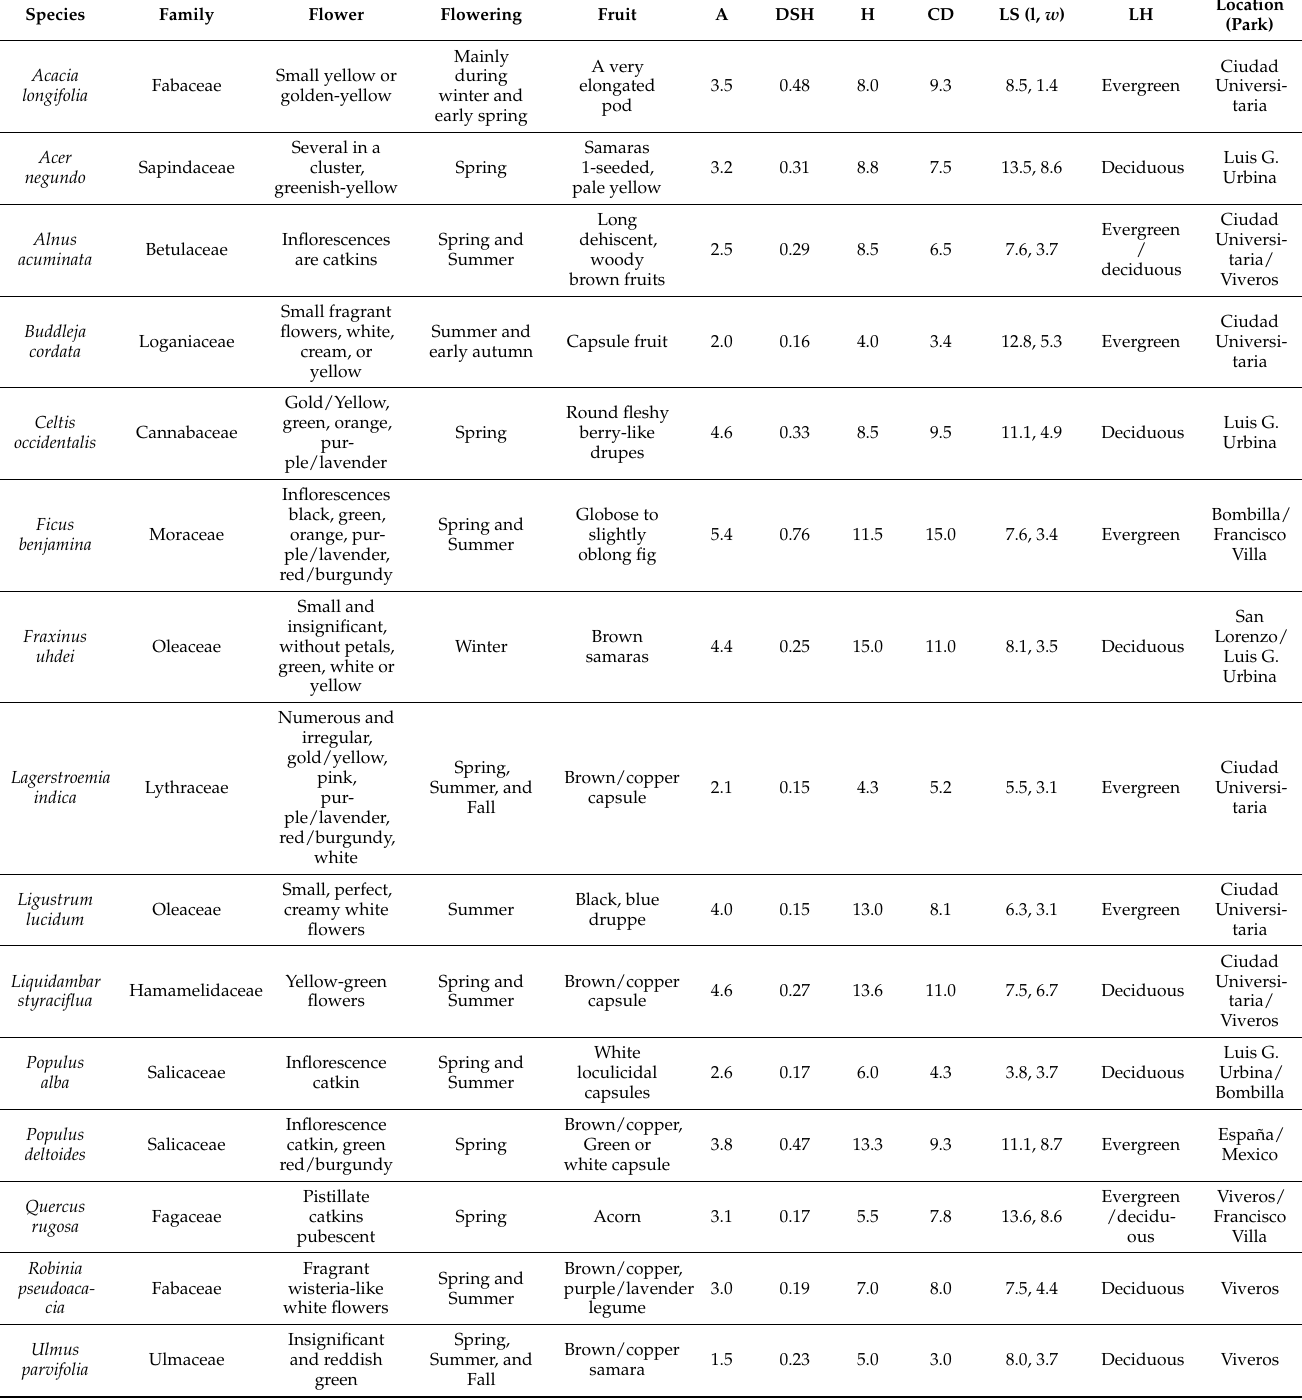
Table 1. Aesthetic characteristics (type of flower and fruit and flowering period), leaf area index (A, m 2 m − 2 ), diameter at standard height (DSH, m), crown diameter (CD, m), leaf size (LS, long (l, cm), wide ( w , cm)), leaf habit (LH) and location for 15 dominant urban tree species ( n = 4 for A, n = 10 for DBH and CD, n = 40 for LS) from eight urban green areas of Mexico